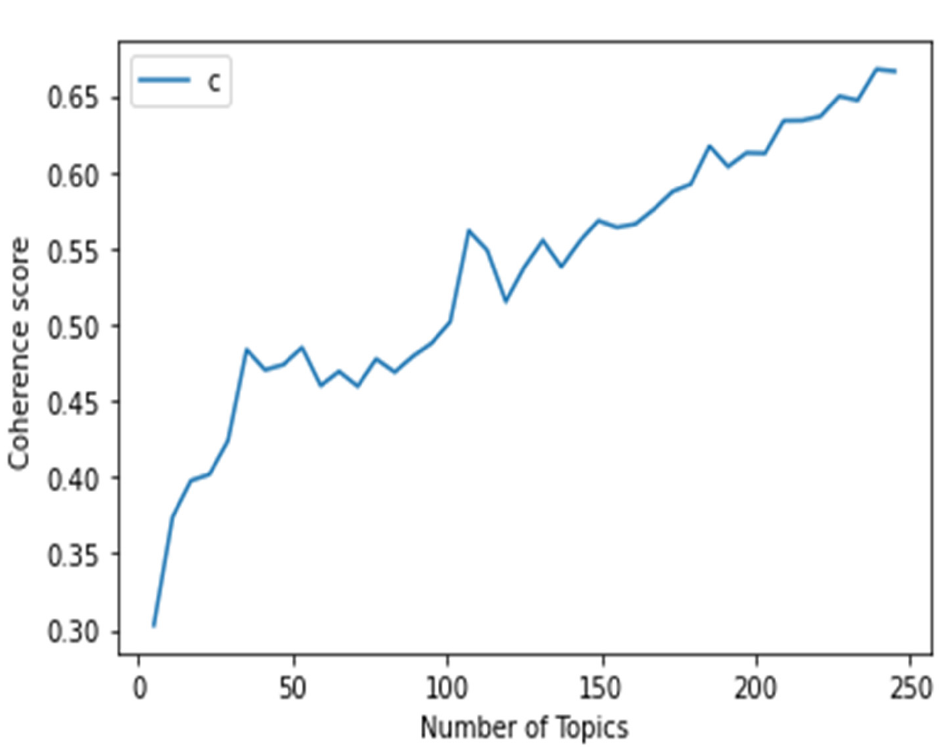
Figure 1. Plot of topics versus coherence score.